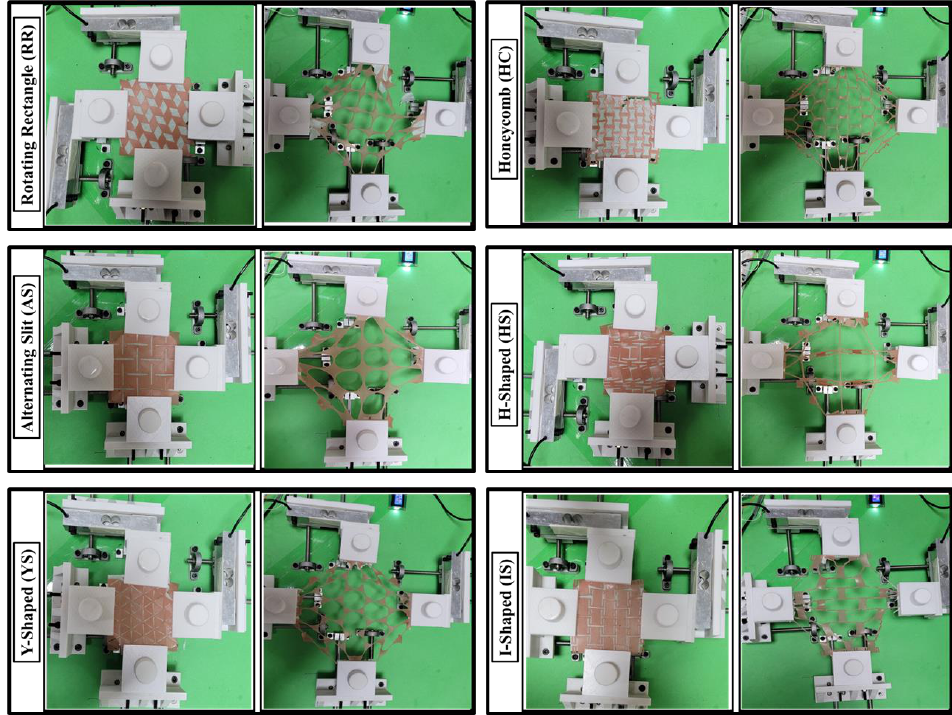
Figure 5. Initial and final deformation of the auxetic skin graft simulants using biaxial testing. Table 1. Void area of different skin graft simulants.